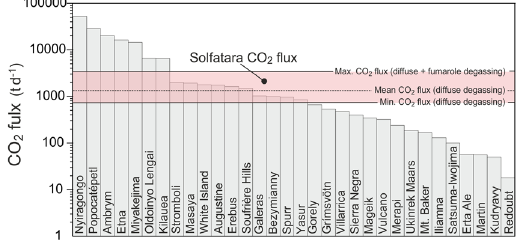
Figure 8. CO 2 fluxes from Solfatara compared to mean volcanic plume CO 2 fluxes from persistently degassing volcanoes (data from ref. 69). For Solfatara, the minimum and average CO 2 flux from diffuse degassing measured for the 1998–2016 period and the maximum CO 2 flux resulting from the sum of diffuse degassing and fumaroles fluxes in the period 2012–2016 are